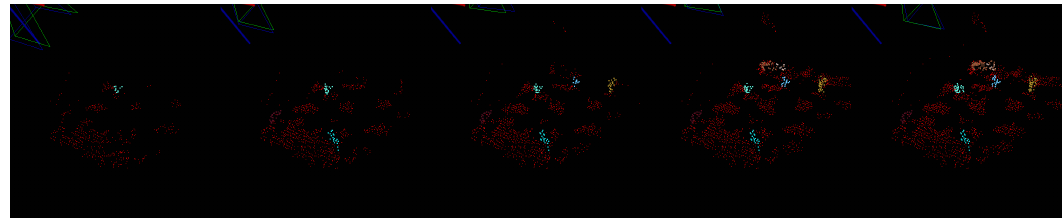
Figure 12. The local map in different iterations. The size of the map is increasing ( red points) and new object candidates are discovered (seen in color).